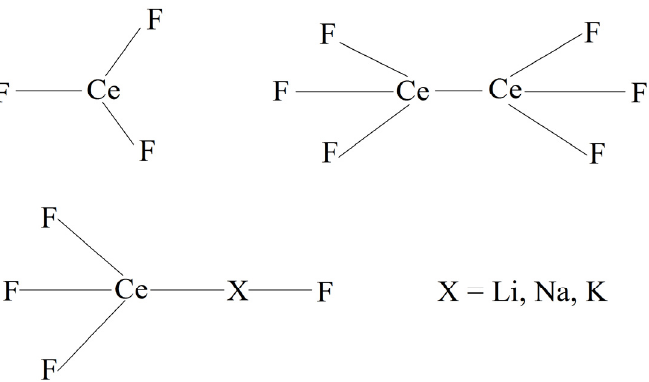
Figure 1. Principal scheme for determining the parameters of the interaction potential between Ce ions and other ions that form the FLiNaK salt mixture. ions and other ions that form the FLiNaK salt mixture.